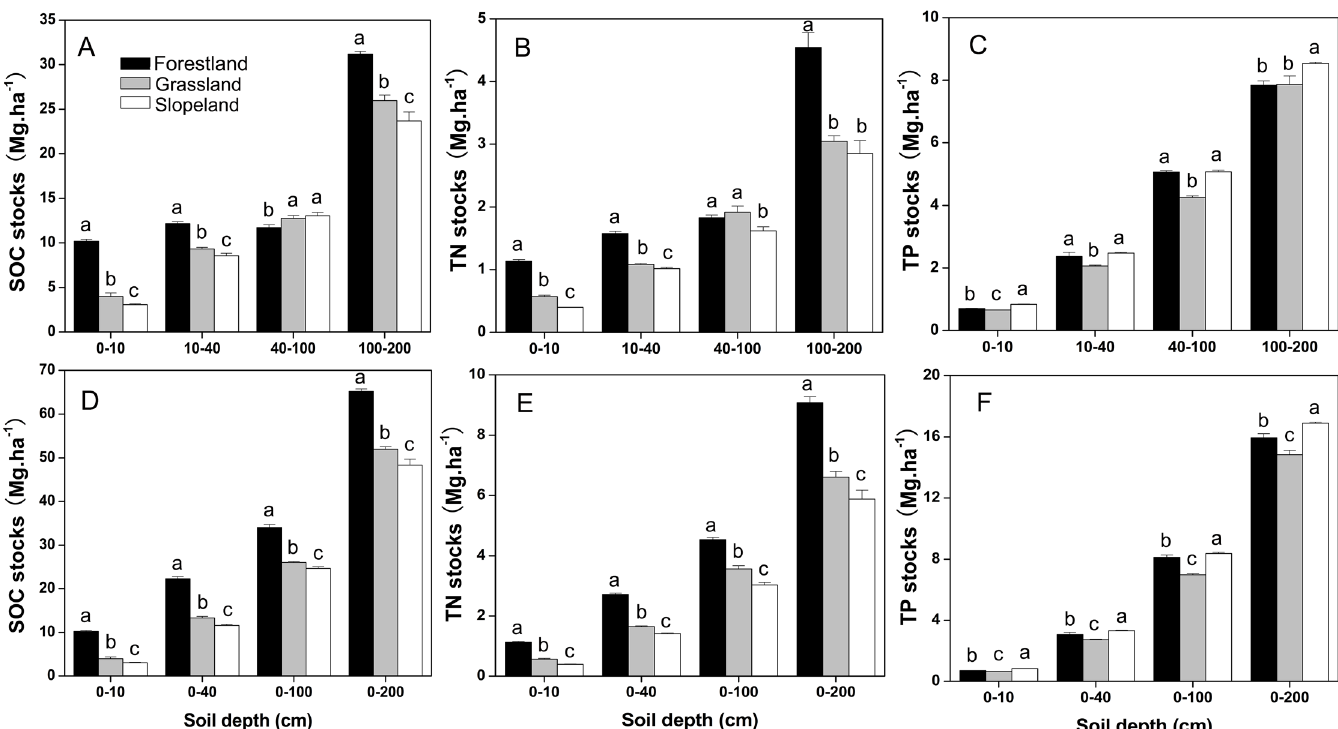
Fig 2. Distribution of SOC stock (A), soil TN stock (B), TP stock (C), cumulative SOC stock (D), soil cumulative TN stock (E) and cumulative TP stock (F) at different soil depths. The error bars are the standard errors. Different lowercase letters indicate significant differences at 0.05 (P < 0.05) levels among different land use types within the same soil